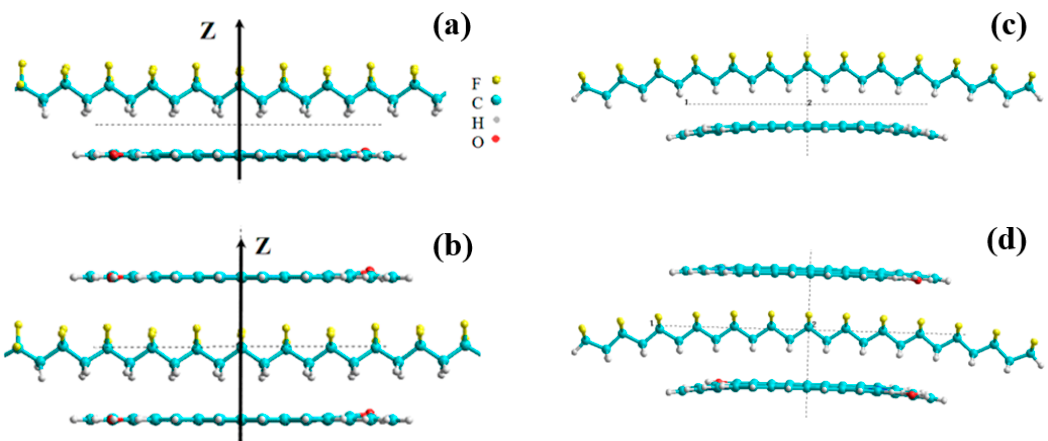
Figure 12. Models of PVDF / graphene oxide structures: ( a ) with H-side, flat PVDF / graphene oxide model (GO with G96H model with OH groups); ( b ) flat sandwich model for graphene oxide / PVDF / graphene oxide (the same case of G96H); PVDF curved chain models with determination the geometry of used radius R and chord L configuration (see on Figure 10c); ( c ) with one H-side case, PVDF / graphene curved model—(PVDF + G96H or PVDF / G96H) (graphene from 96 carbon atoms arranged by hydrogen atoms); ( d ) a curved sandwich model with two layers of GO from G96H and OH group for the graphene oxide / PVDF / graphene oxide—(PVDF + 2Gr96HN 2 O 2 H 2 or GO2 / PVDF / GO2).